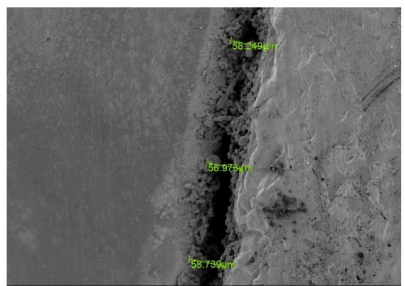
Figure 3. A side view measurement under SEM. Green line—circumferential marginal gap